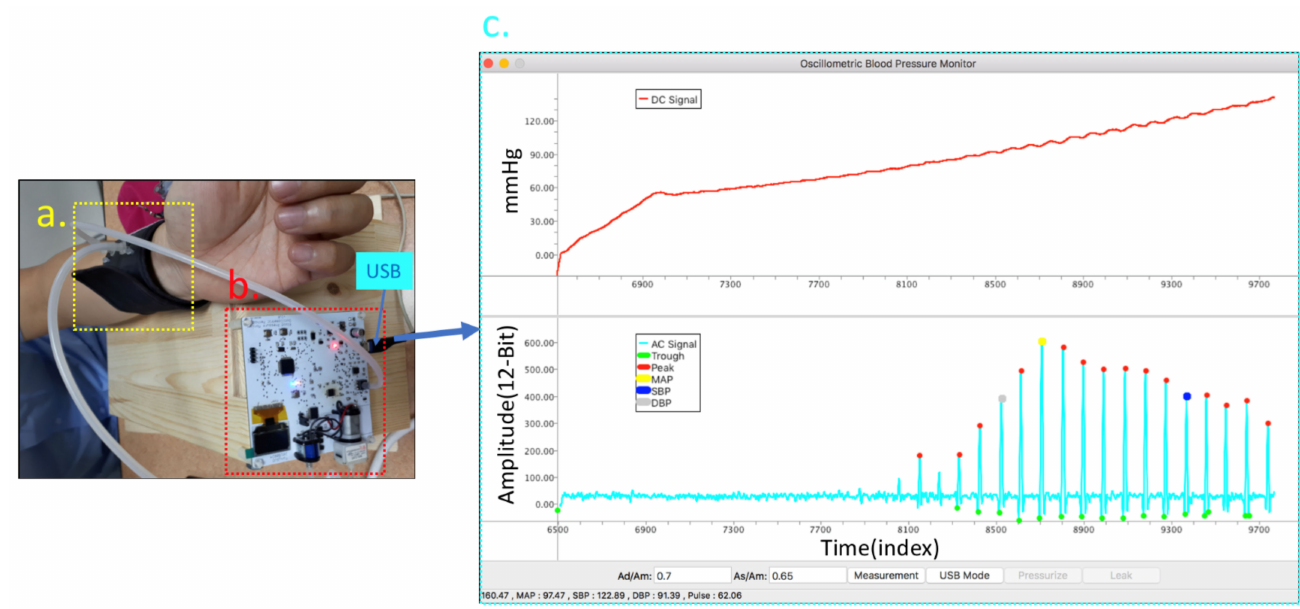
Figure 10. Blood pressure measurement device: ( a ) wrist cuffs based on the principle of the oscillometric method, ( b ) Wheatstone bridge pressure sensor, ( c ) electronic sphygmomanometer air pump.